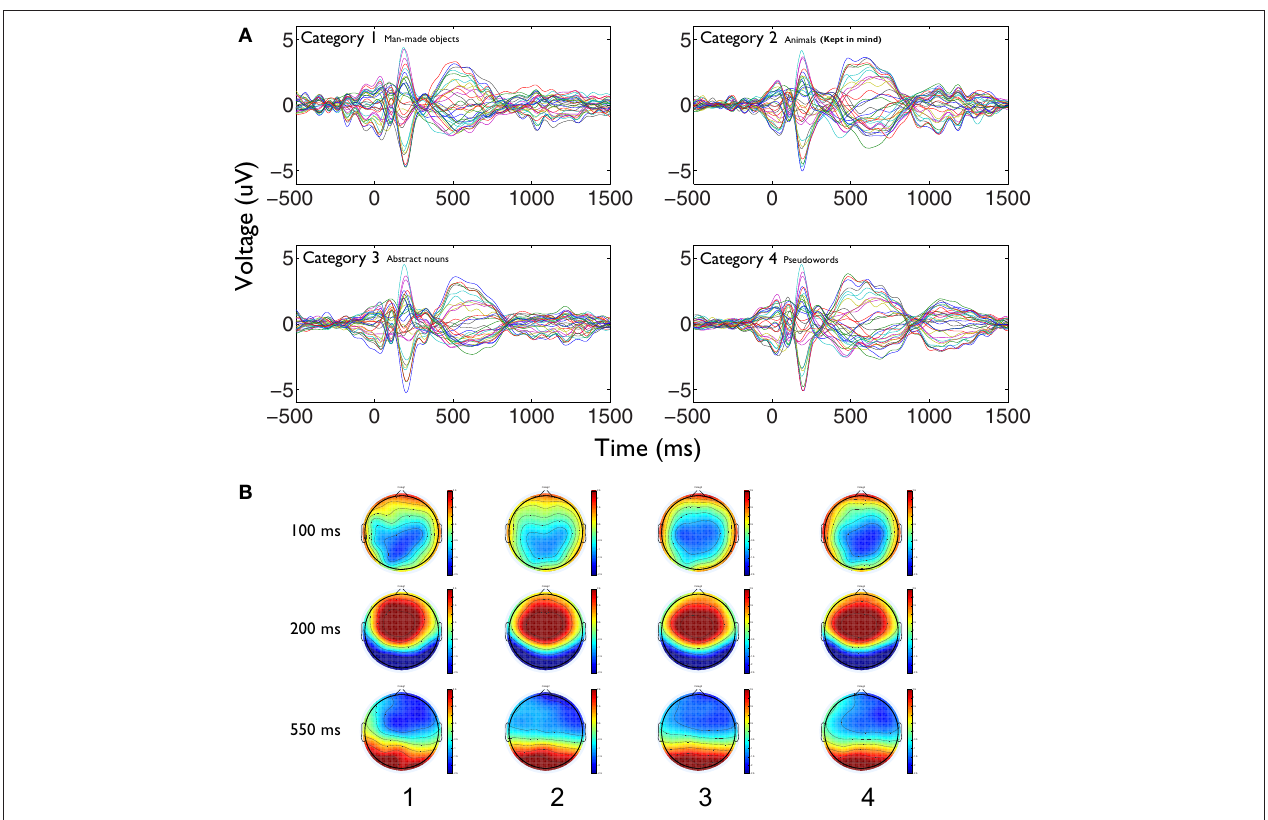
FIGURE 5 | Stronger phase synchronization for the kept in mind category is not related to the appearance of event related evoked activity. (A) Event related potentials are displayed as overlaid traces of recording electrodes between − 500 and 1500ms around stimulus presentation for each category. Epochs time series were filtered between 0.01 and 20Hz. Kept in mind category (above right) does not shows specific components at any latency that could relate to the